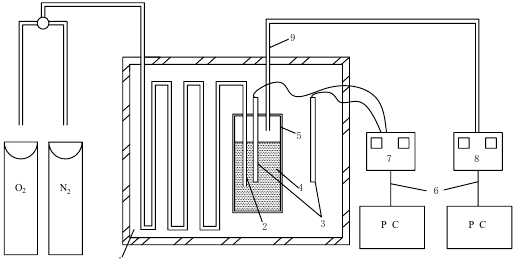
Figure 1. Experimental principle of adiabatic oxidation. 1. Insulated box, 2. Inlet port, 3. Temperature sensor, 4. Coal, 5. Adiabatic oxidation bottle, 6. Data collection, 7. Temperature controller, 8. Gas chromatograph, 9. Escape port.